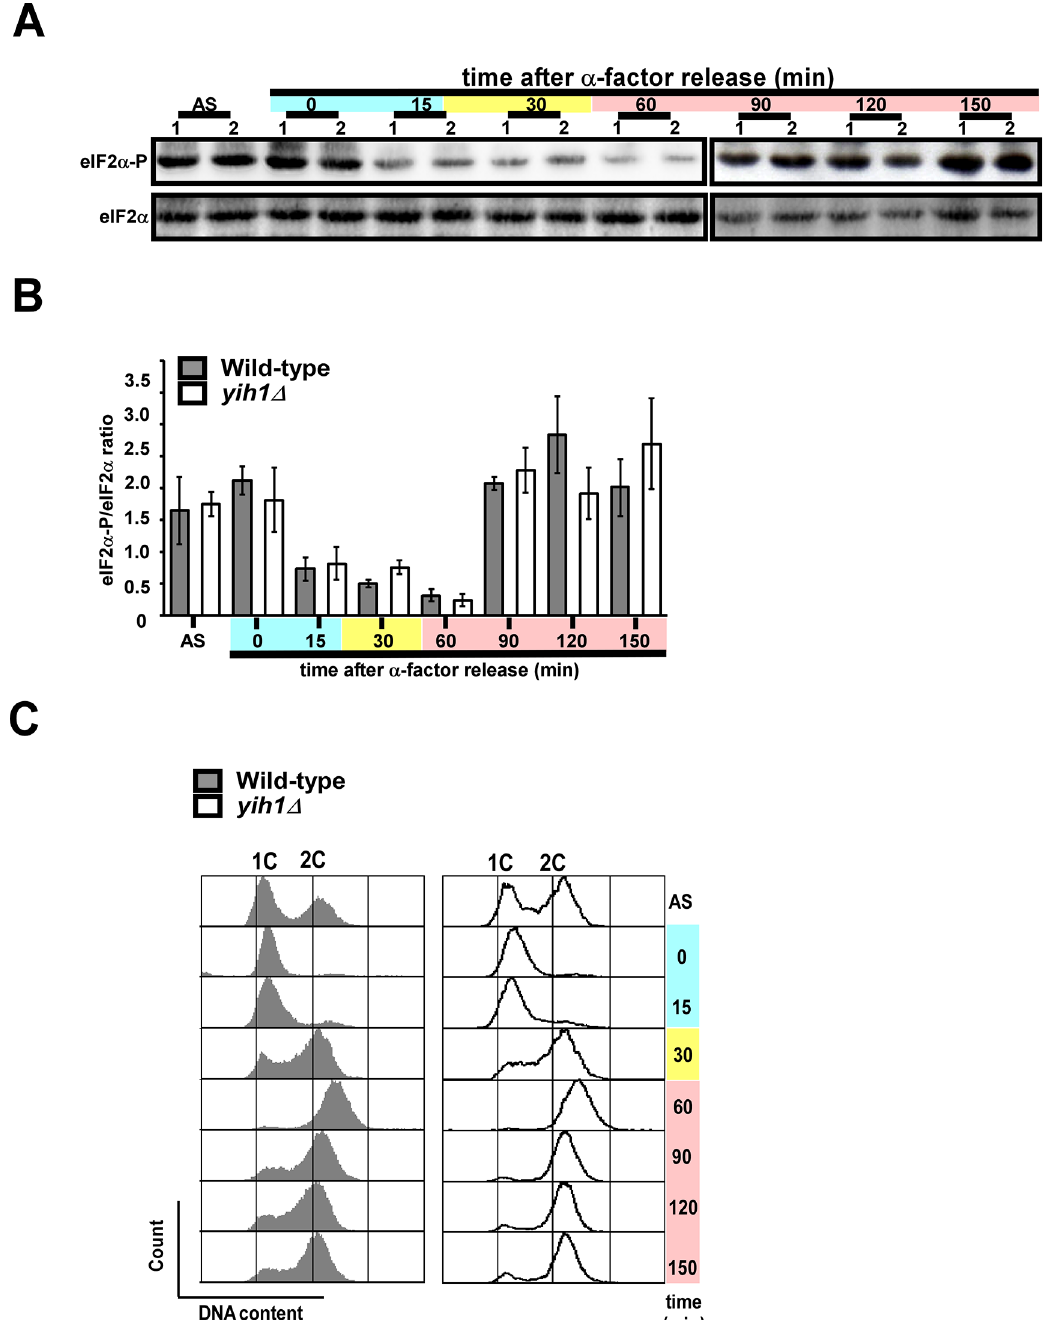
Fig 4. Phosphorylation of eIF2 α along the cell cycle. Exponentially growing wild type (MSY-WT2) and yih1 Δ (MSY-Y2) cells were arrested in G1 with α - factor and released into fresh SD media. Samples were collected at the indicated time intervals. (A) WCEs of these cultures and of an asynchronous culture (AS) were subjected to immunoblot analysis, using antibodies against eIF2 α phosphorylated on Ser-51 (eIF2 α -P) and against total eIF2 α . (B) Immunoblot signals from three independent blots as shown in (A) were quantified using the NIH Image J software, the ratios between eIF2 α -P and eIF2 α were determined and the results were normalized using the value of the ratio of the asynchronous cells (AS); values represent means ± S.E.. (C) Representative histograms. Flow cytometry analysis of DNA content of the samples used in (A). Blue, yellow and pink shaded boxes indicate the estimated G1, S and G2/M cell cycle stages,